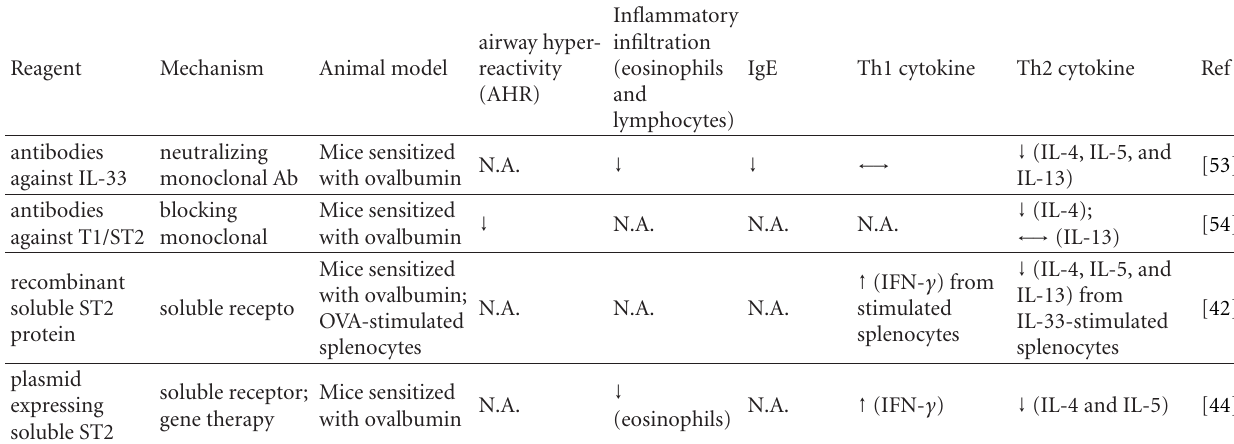
Table 2: E ff ect of therapeutic experiments Targeting ST-2/IL-33